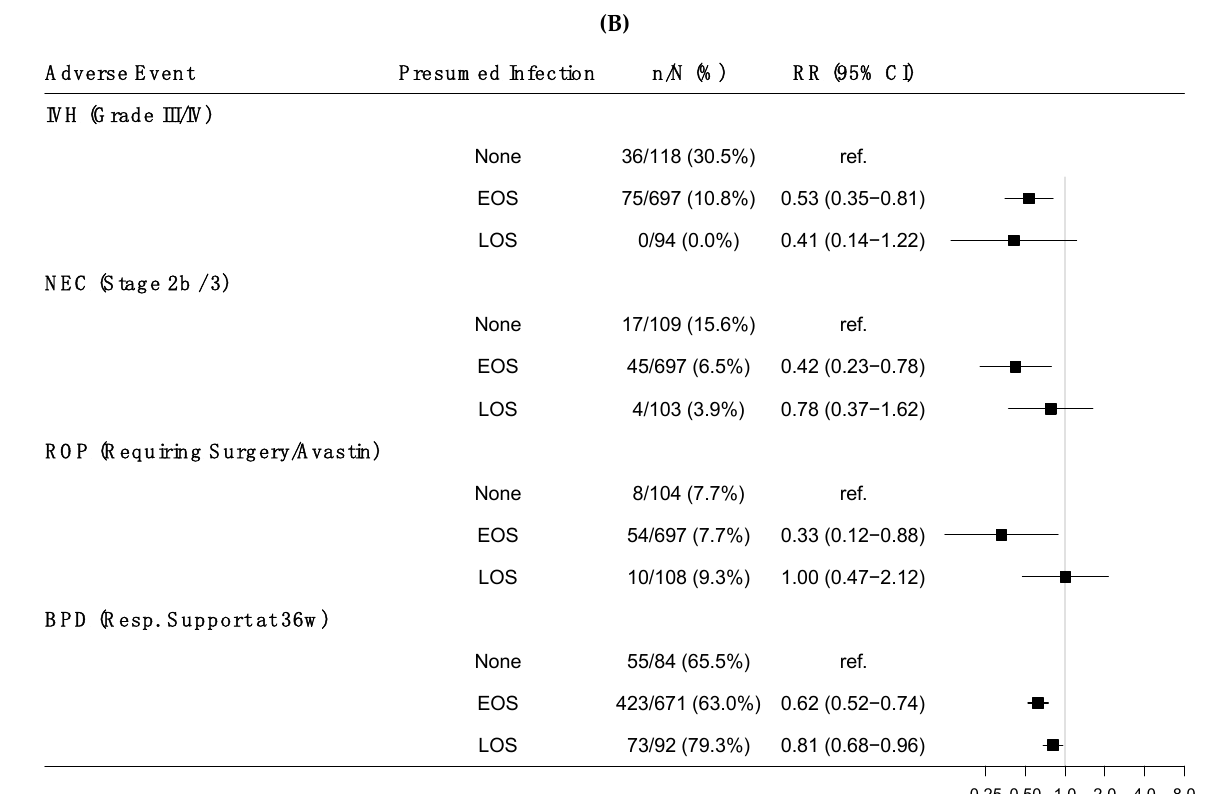
Figure 3. Forest plot of predictors of safety outcomes by confirmed ( A ) and presumed ( B ) early and late onset sepsis. Significant differences were noted for confirmed late onset sepsis and risk of death and necrotizing enterocolitis ( A ). Significant differences were noted for presumed early onset sepsis across all safety outcomes and for presumed late onset sepsis only for risk of bronchopulmonary dysplasia ( B ). EOS, Early onset sepsis; LOS, Late onset sepsis; IVH, intraventricular hemorrhage; BPD, bronchopulmonary dysplasia; NEC, necrotizing enterocolitis; ROP, retinopathy of prematurity.